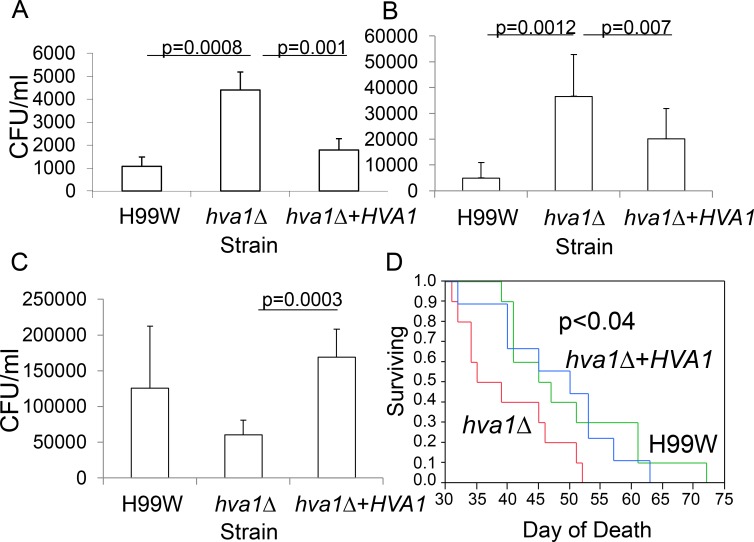
The hva1Δ strain has a hypervirulent phenotype.Mouse fungal burden in the spleen (A), brain (B) and lungs (C) of mice infected intravenously with the pre-passage H99W, the hva1Δ and hva1Δ+HVA1 strains. Six mice were infected for each group. Error bars depict standard deviation. D) Survival data for mice infected intravenously with the pre-passage H99W, the hva1Δ and hva1Δ+HVA1 strains. Ten mice were infected for each group (only 9 mice reported for H99W).